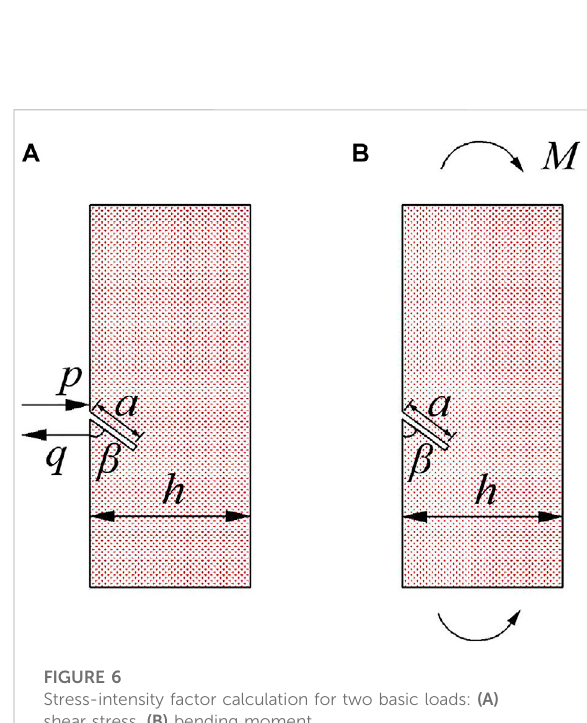
FIGURE 6 Stress-intensity factor calculation for two basic loads: (A) shear stress, (B) bending